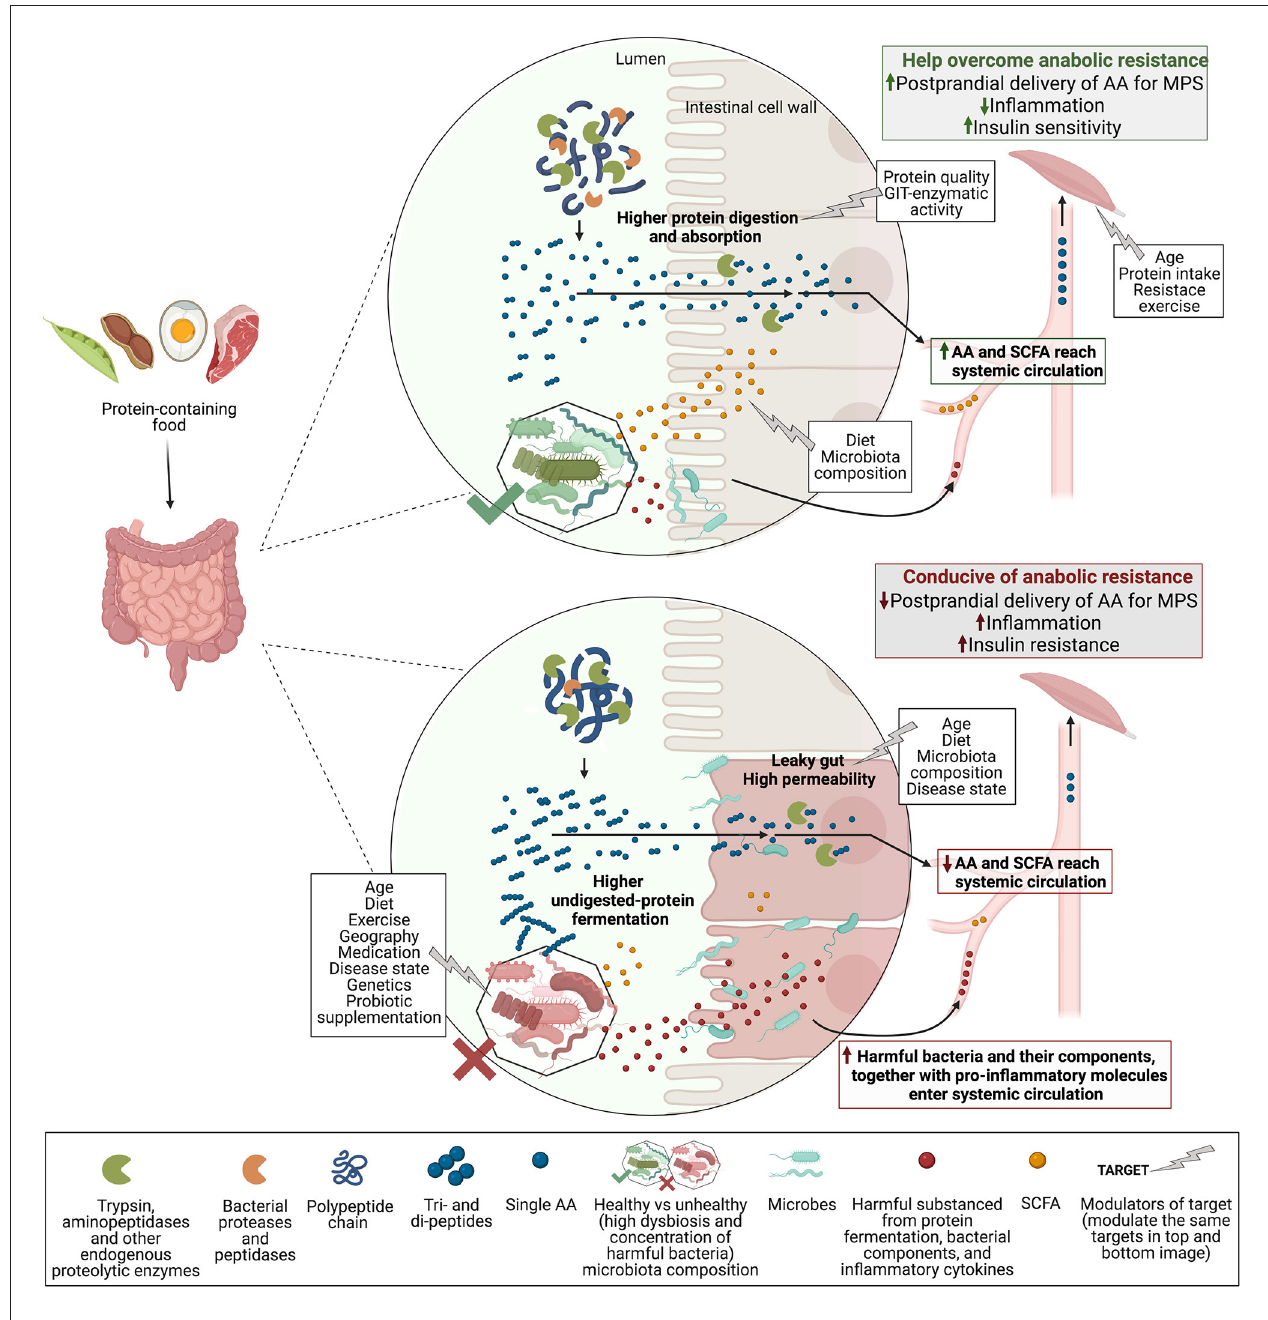
FIGURE 1 | Proposed the gut microbiota role in protein digestion and absorption, and related MPS response. Polypeptides from protein-containing foods enter the duodenum and are cleaved by enzymes into di- and tripeptides, and some single AA, which are absorbed by enterocytes (intestinal cell wall). Aminopeptidases of enterocytes cleave di- and tripeptides into single AA that can now enter systemic circulation after first-pass splanchnic retention. In the lumen, enzymes of gut microbes or probiotics may aid with the polypeptide and shorter peptides cleavage to increase AA delivery to the bloodstream. Undigested peptides reach the colon and are fermented by the gut microbiota to release molecules like ammonia and hydrogen sulphide (harmful), and SCFA (in lesser amounts, SCFAs are mainly ferments of undigested carbohydrates). A healthy gut microbiota composition (high concentration of beneficial microbes and diversity) may release higher amounts of SCFA and is better able to control the translocation of harmful substances from the lumen into circulation. SCFA can improve gut permeability and may positively modulate muscle biology. Reduced translocation of proinflammatory molecules is linked to lower systemic inflammation and may positively influence insulin sensitivity in the muscle. Opposingly, unhealthy gut microbiota is associated with a leaky gut, which is less able to regulate the harmful translocation into the bloodstream of microbes (e.g., Bacteroides sp .) and their components (e.g., LPS), as well as proinflammatory cytokines, all likely to be found in an “unhealthy” GIT. This leads to